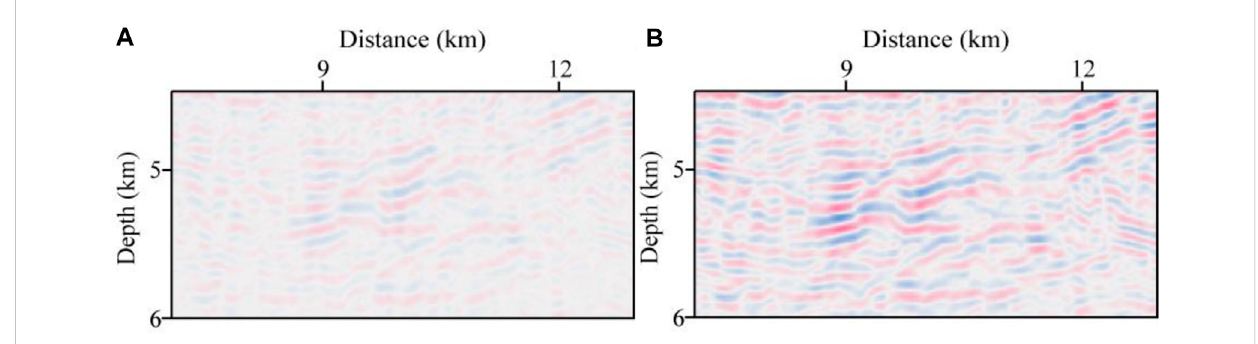
FIGURE 17 Zoom-in of the migrated image (A) acoustic RTM (B) constant-order compensated RTM.